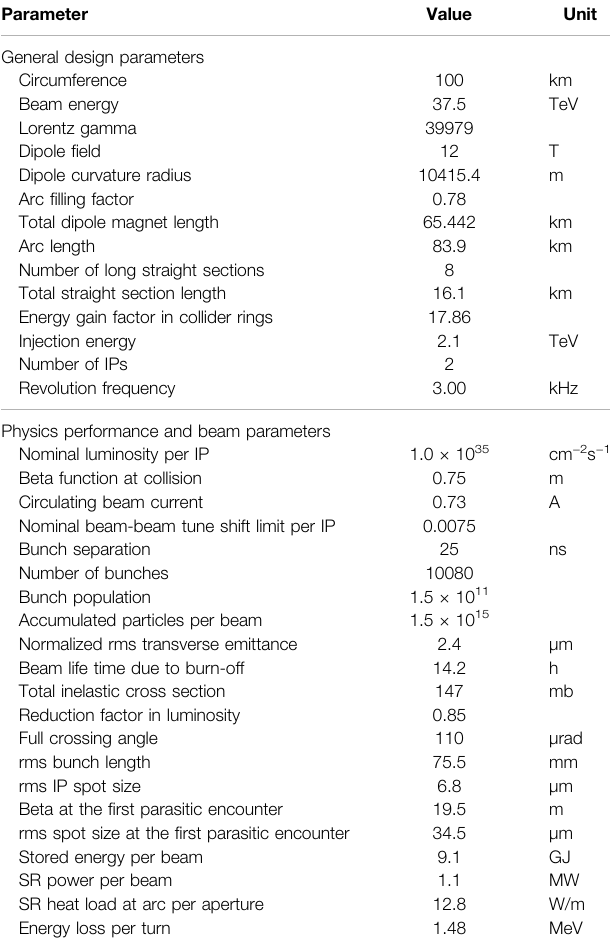
TABLE 2 | Main SPPC